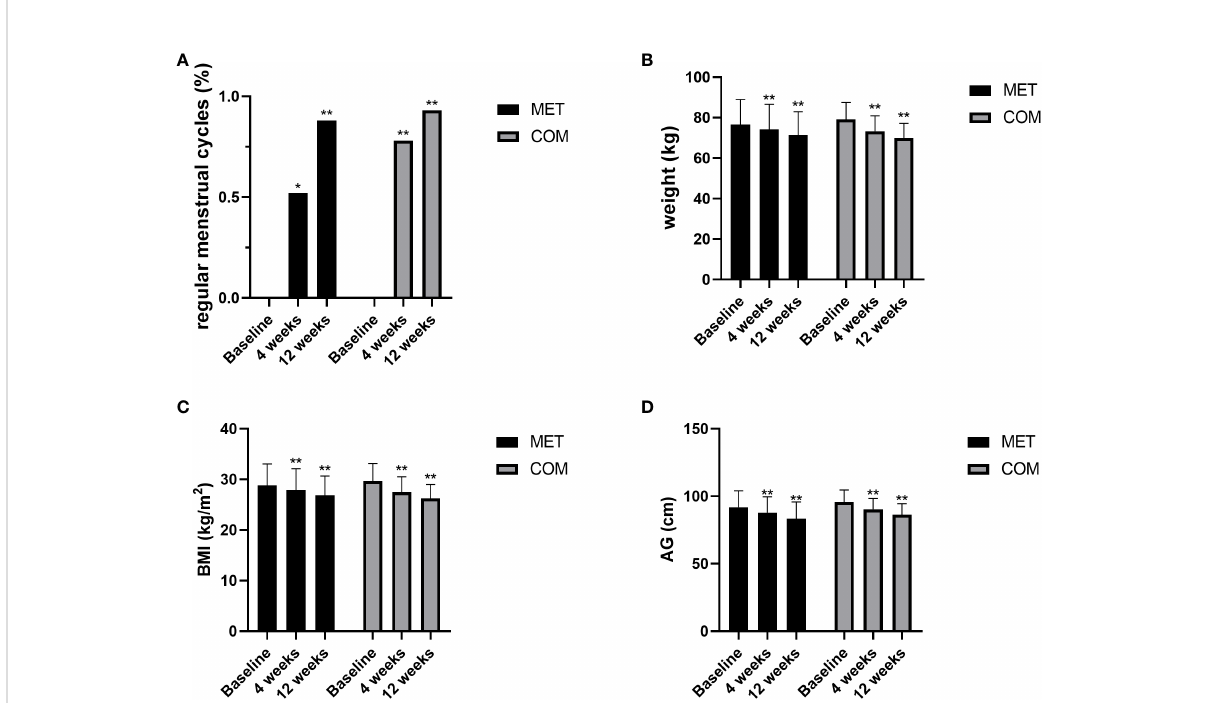
FIGURE 2 Changes in menstruation and anthropometric measurements after MET and COM therapy. (A) Changes in menstrual cycles after MET and COM therapy. (B) Changes in weight after MET and COM therapy. (C) Changes in BMI after MET and COM therapy. (D) Changes in AG after MET and COM therapy. MET, metformin; COM, combine; BMI, body mass index; AG, abdominal girth. Results are expressed as mean ± SD; * P < 0.05, ** P < 0.01 (vs. before treatment in each